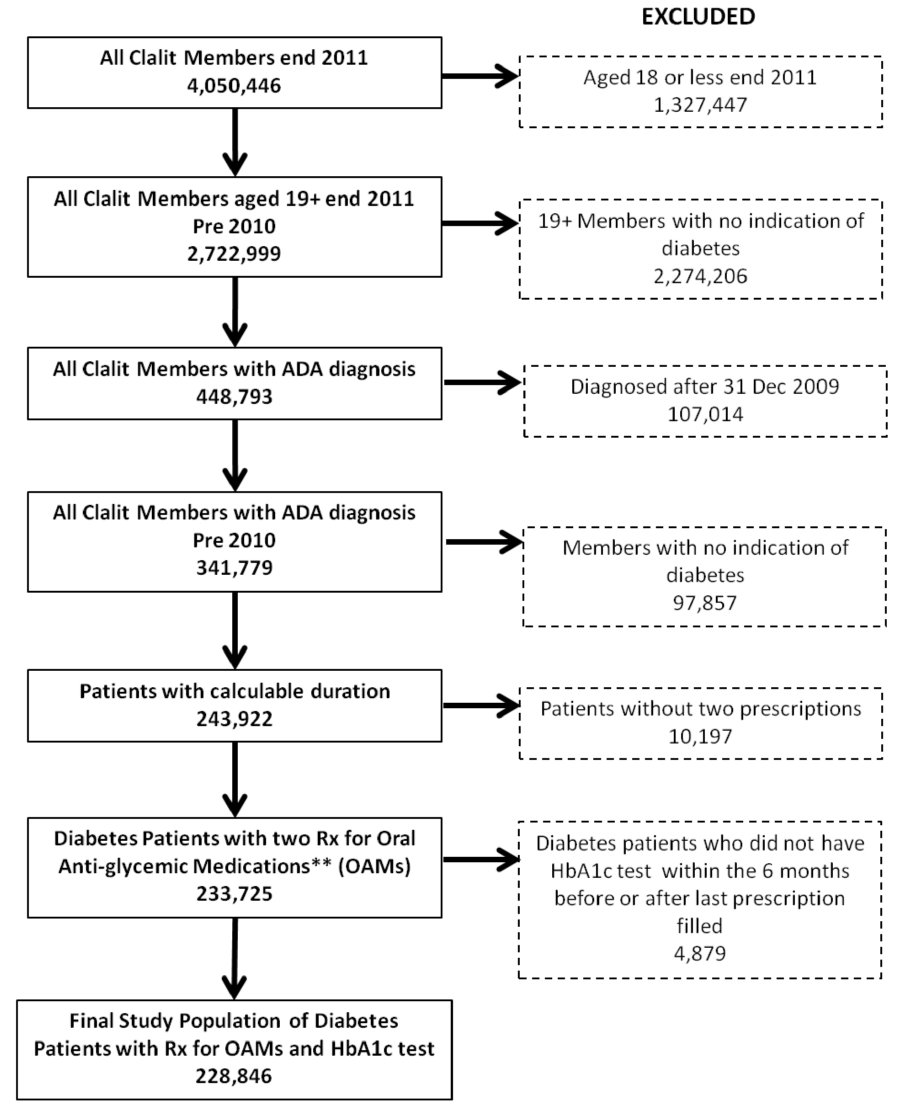
Figure 1. Patient exclusions flow chart. The figure shows the process for arriving at the final sample size. After all exclusion criteria were applied, a final study population of 228,846 patients with diabetes who had a prescription for oral anti-glycemic medications and an HbA1c test performed was yielded.